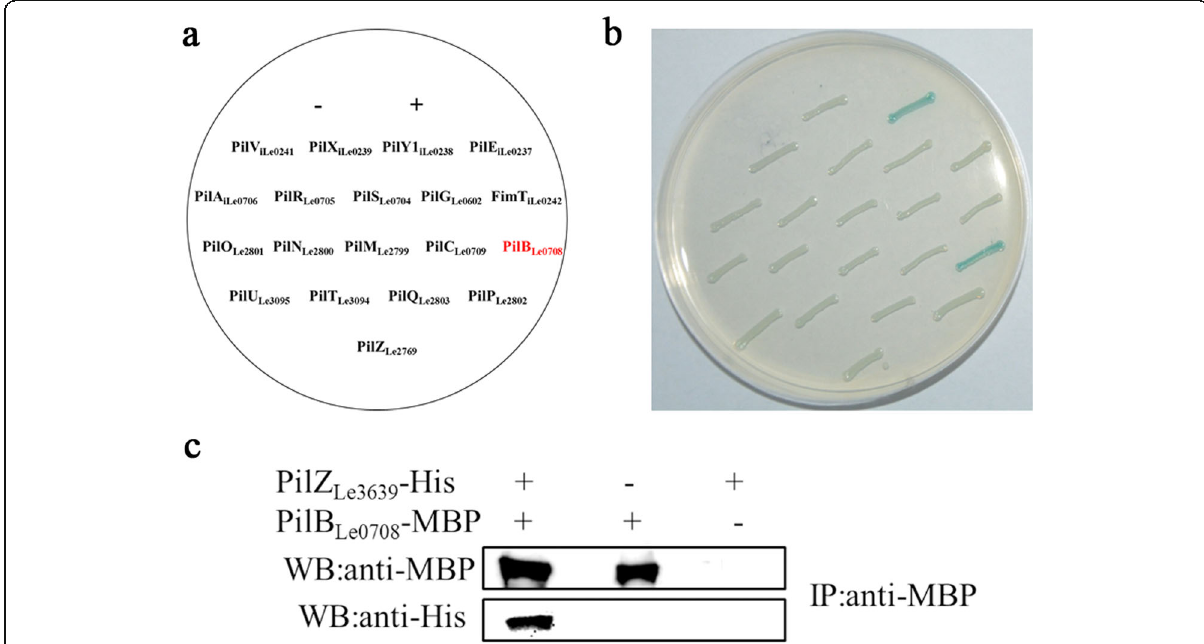
Fig. 3 PilZ Le3639 directly interacted with PilB Le0708 , a characterized pilus motor protein . a, b pKT25-PilZ Le3639 with the recombinant pUT18c carrying different pilus-associated proteins that are required for twitching motility in L. enzymogenes OH11 (Xia et al. 2018) were co-transformed into the E. coli BTH101 cells to test their potential protein-protein interactions by the bacterial adenylate cyclase two-hybrid (BACTH) system. The co-transformed E. coli colony with a “ blue ” color indicated the test protein-protein interactions happened under the test conditions. Using this approach, only PilB Le0708 with PilZ Le3639 showed an interaction signal. “ + ” , a positive control (pUT18c-Zip &pKT25-Zip), “ - ” , a negative control (pUT18c &pKT25). c GST pull-down assay confirmed the direct binding of PilZ Le3639 with PilB Le0708 in